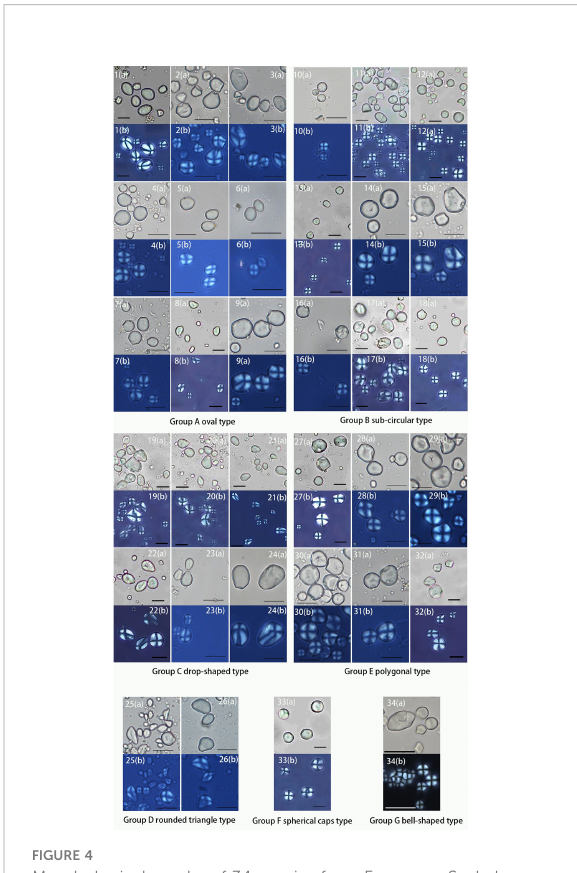
FIGURE 4 Morphological graphs of 34 species from Fagaceae. Scale bar, 20 m m. (a, bright fi eld light; b, cross-polarized light). 1, Quercus blakei; 2, Quercus argyrotricha ; 3, Quercus augustinii ; 4, Quercus litseoides ; 5, Quercus kouangsiensis ; 6, Quercus fl euryi ; 7, Quercus lamellosa ; 8, Quercus serrata ; 9, Quercus sessilifolia ; 10, Lithocarpus fenzelianus ; 11, Quercus gilva ; 12, Lithocarpus elizabethiae ; 13, Lithocarpus pachylepis ; 14, Lithocarpus sp.; 15, Lithocarpus longipedicellatus ; 16, Lithocarpus xylocarpus ; 17, Quercus kiukiangensis ; 18, Quercus schottkyana ; 19, Quercus longispica ; 20, Castanea seguinii ; 21, Quercus marlipoensis ; 22, Quercus cocciferoides ; 23, Quercus franchetii ; 24, Quercus phanera ; 25, Quercus aliena ; 26, Quercus variabilis ; 27, Lithocarpus craibianus